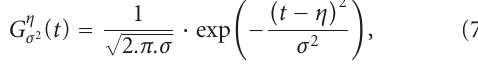
After considering them, we find that the function exhibits semi-Gaussian behavior during gradual transitions. Figure 2 shows some instances of these